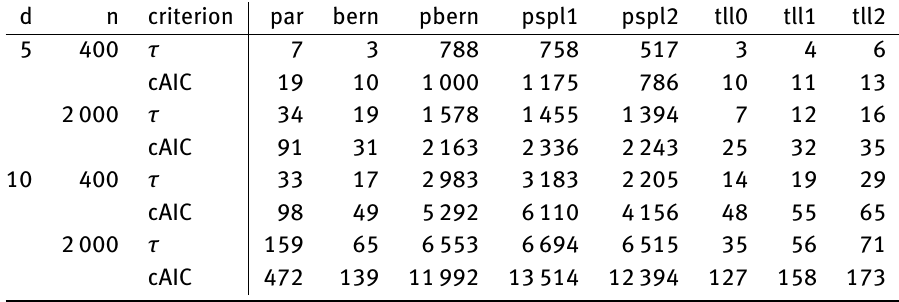
Table 3: Average computation time (in seconds) required for estimation and selection of one vine copula model. d n criterion par bern pbern